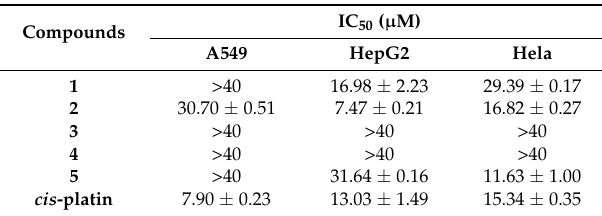
Table 2. In Vitro Cytotoxic Activities of Compounds 1 – 5